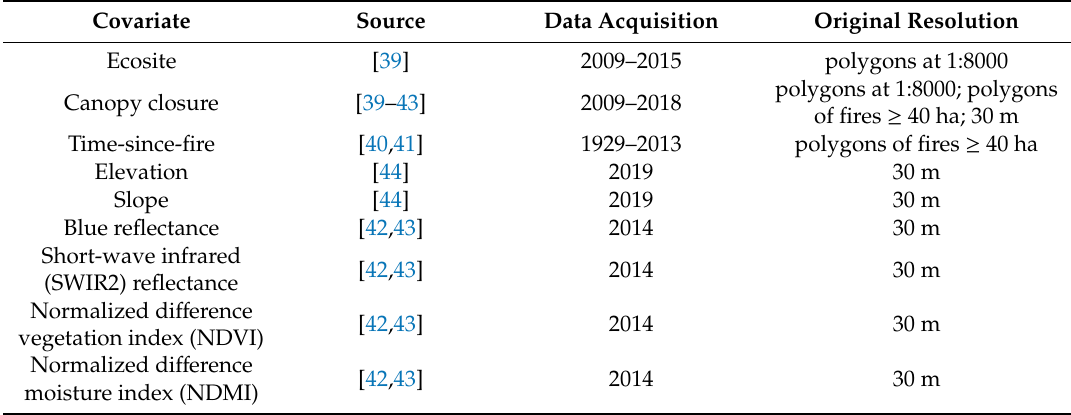
Table 2. Description of covariates used to model lichen presence and abundance as a function of forest structure, topographic and remote sensing attributes. Additional descriptions of each covariate layer are provided in Appendix